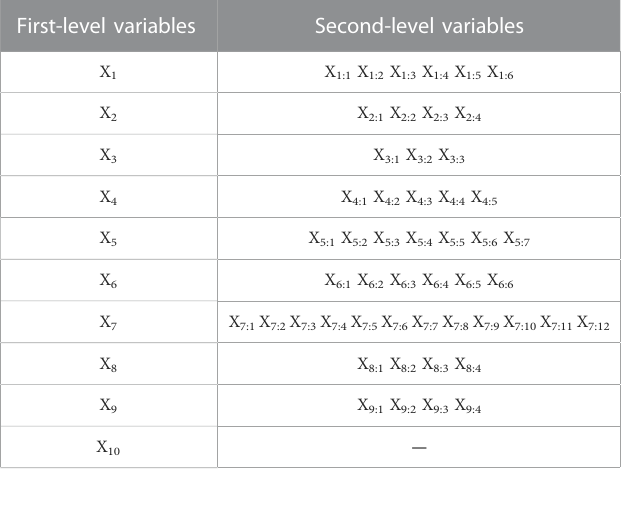
TABLE 3 Multiple input-output table of MSWSM Policy. First-level variables Second-level variables